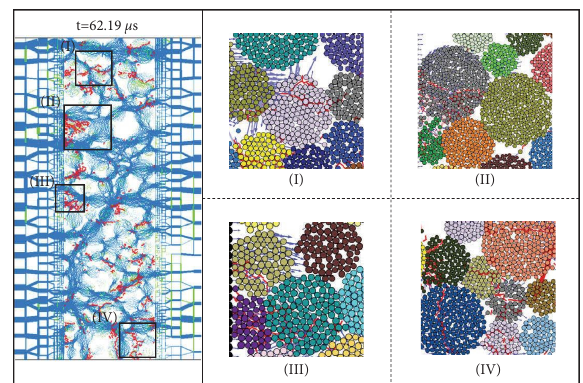
Figure 11: Breakage mode of the sand specimen during the nu- merical compression test (stage C).